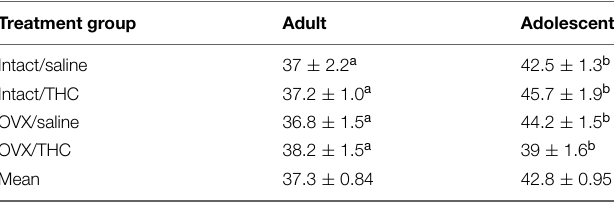
TABLE 1 | Mean number of days required to train the subjects under the behavioral procedure during chronic administration. Treatment